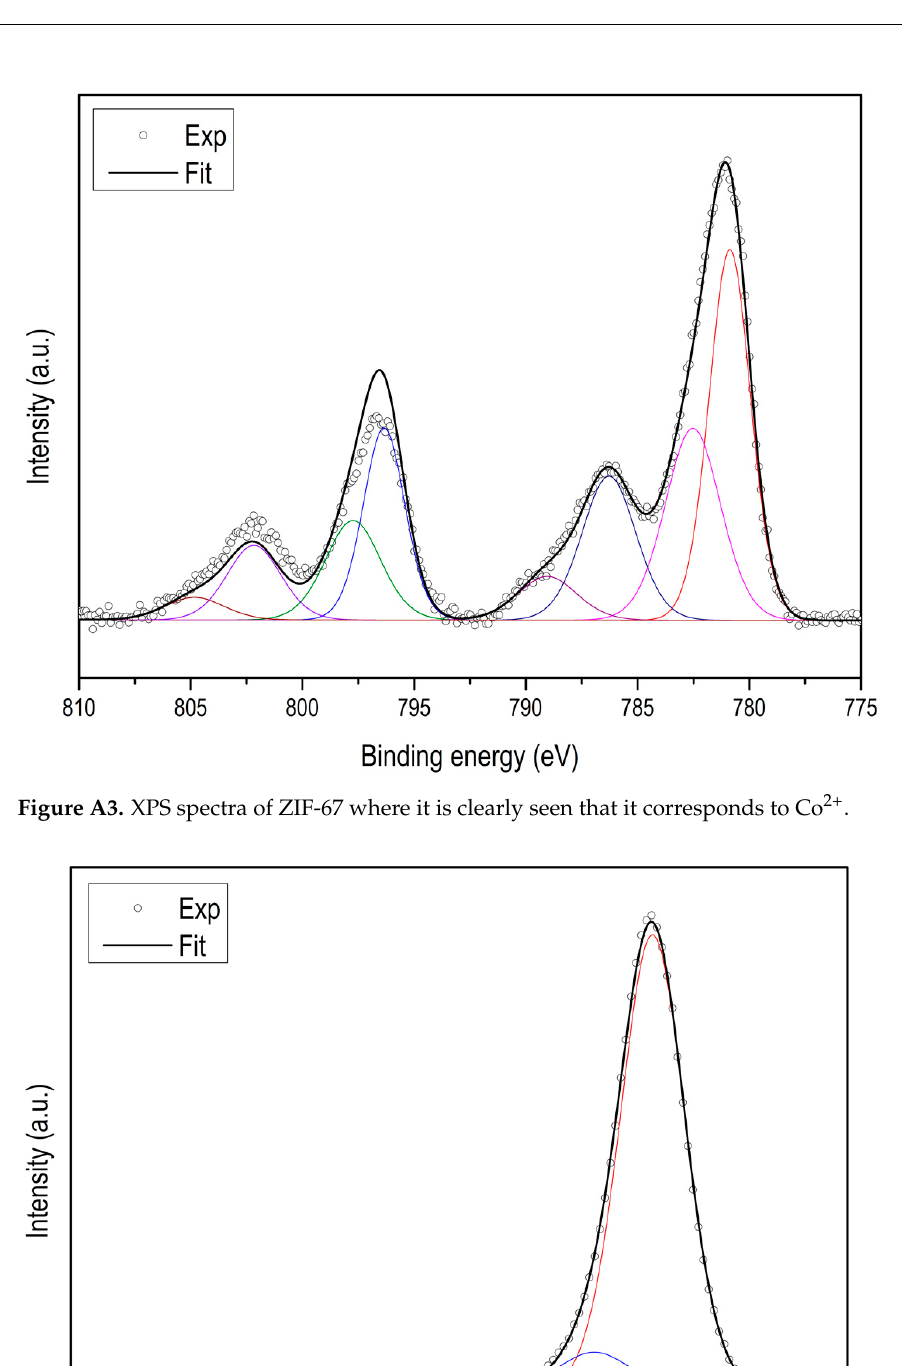
Figure A2. SEM micrograph of ZIF-67.